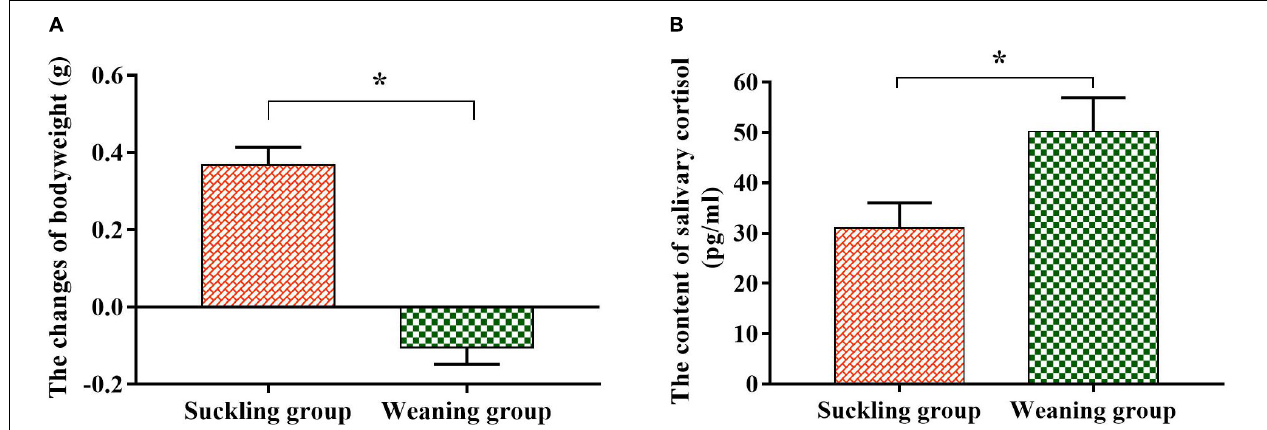
FIGURE 1 | The changes of the bodyweight and salivary cortisol content of piglets. (A) Bodyweight change; (B) salivary cortisol content. Graph shows means value ± SEM ( N = 7). *( P < 0.05) means significant difference between the suckling group (orange column) and the weaning group (green column).